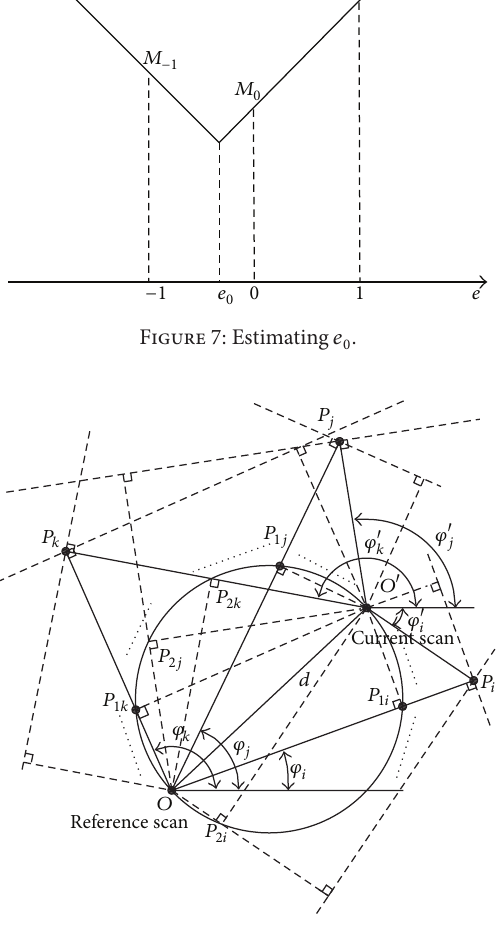
Figure 8: The projection